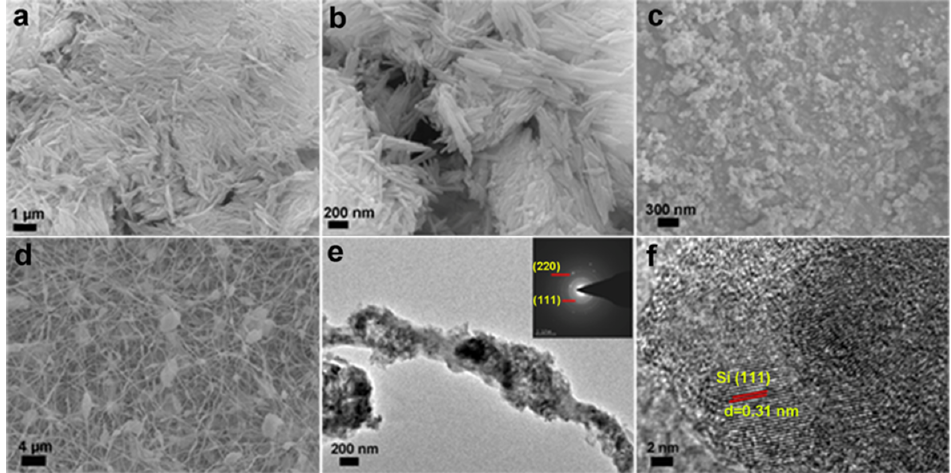
Figure 3. SEM images of ( a ) original halloysite clay; ( b ) obtained H-SiO 2 after selective acid etching;